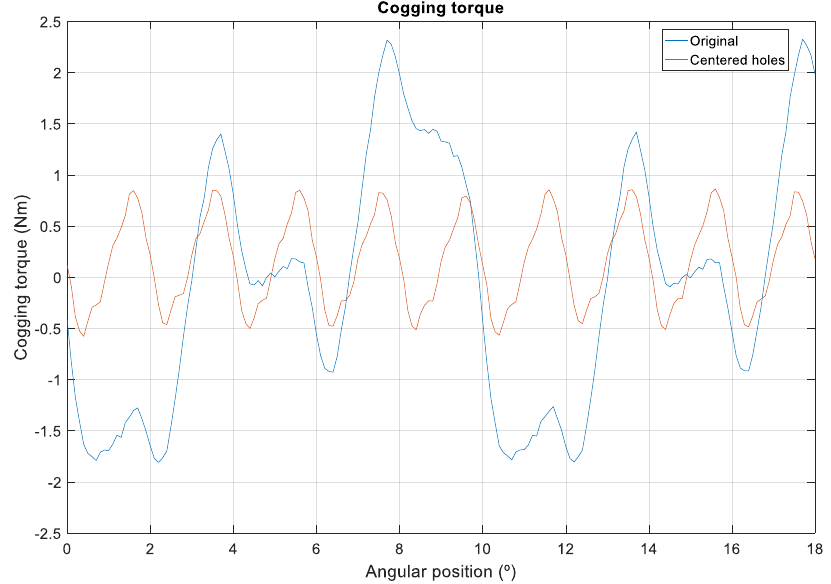
Figure 13. Cogging torque of the original PMSG and model with centered holes.